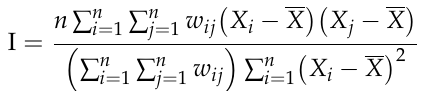
Figure 3. Method and technical process for the geographic identification of rural poverty.